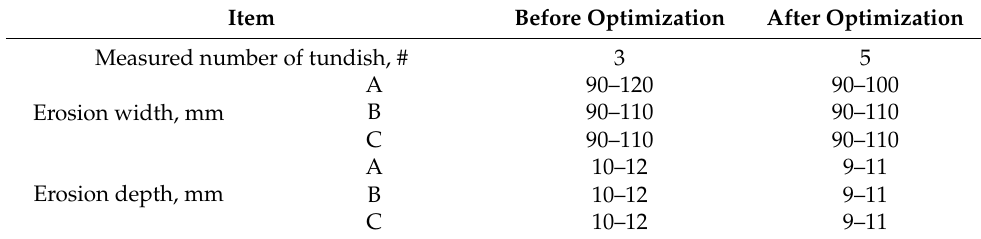
Figure 8. Schematics of erosion examination locations. Table 8. Erosion state of the working layer in tundish.